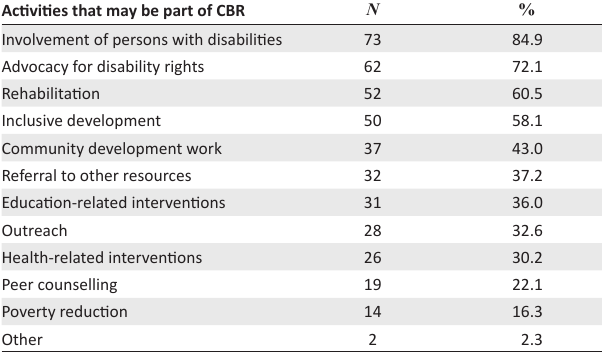
TABLE 3: Important aspects of community-based rehabilitation ( N = 86) (multiple responses allowed).